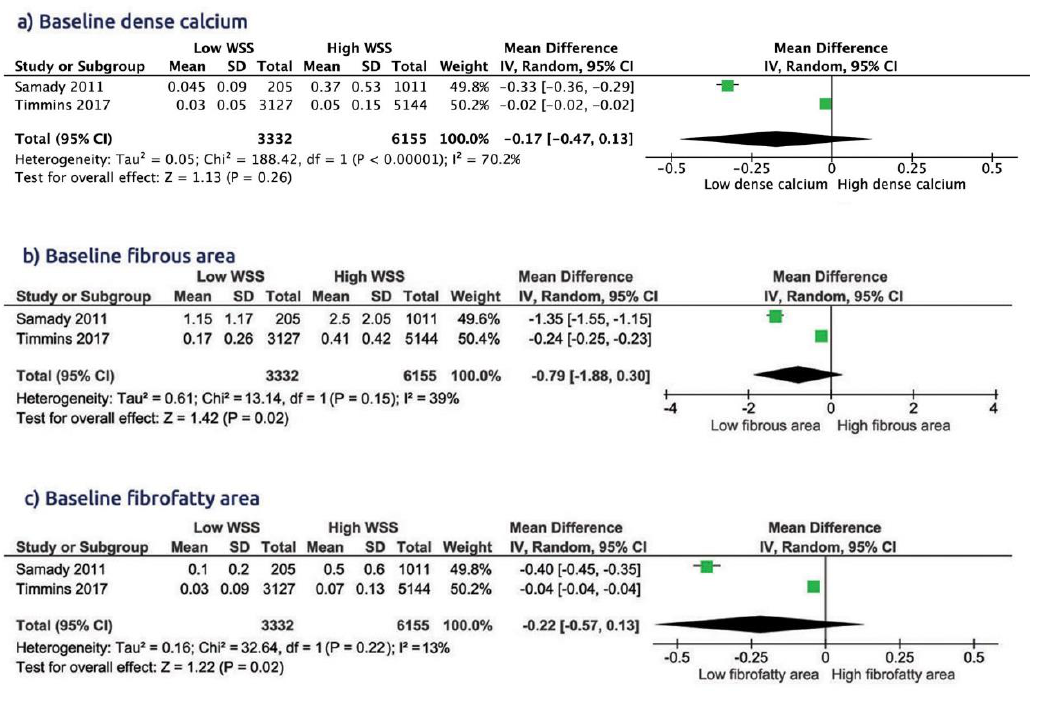
Figure 3. Comparison of baseline dense calcium, fibrous area, and fibro-fatty area in group of low WSS vs. high WSS.